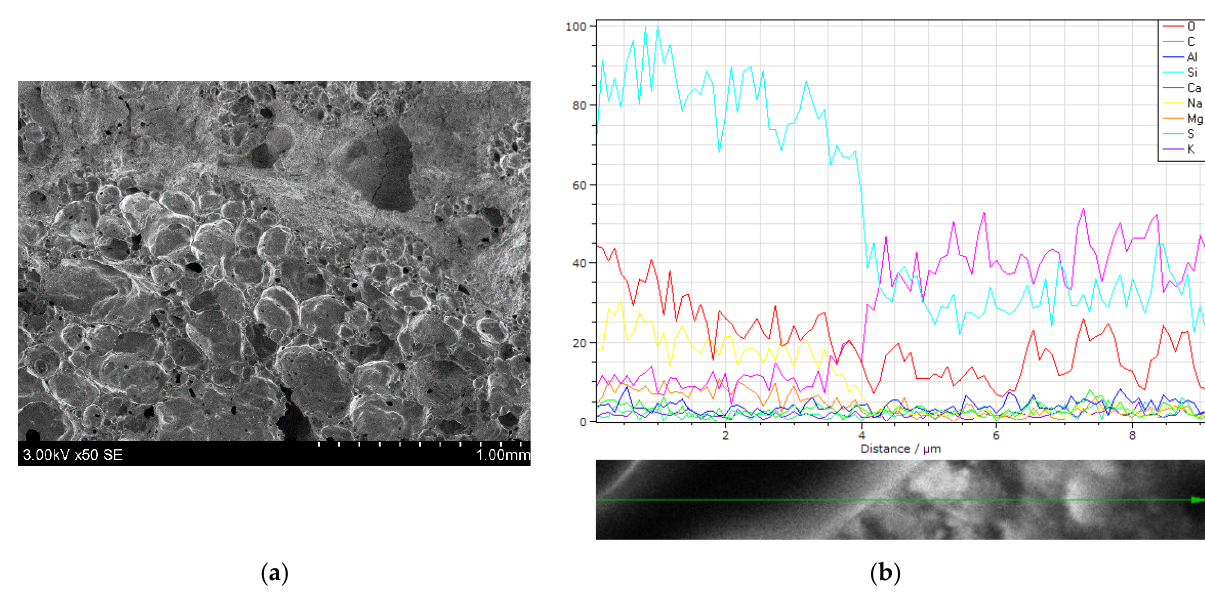
Figure 8. SEM images of the hardened cement paste samples containing expanded glass ( a ) and the elemental composition of transition zone for EG and hardened cement paste, according EDX analysis ( b ).